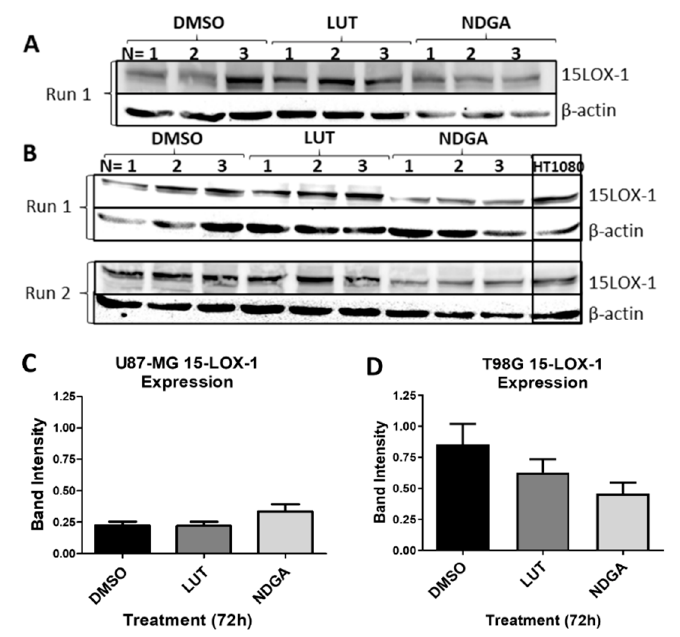
Figure 8. Western blots of 15-LOX-1 expression after treatments with LOX inhibitors luteolin (LUT)